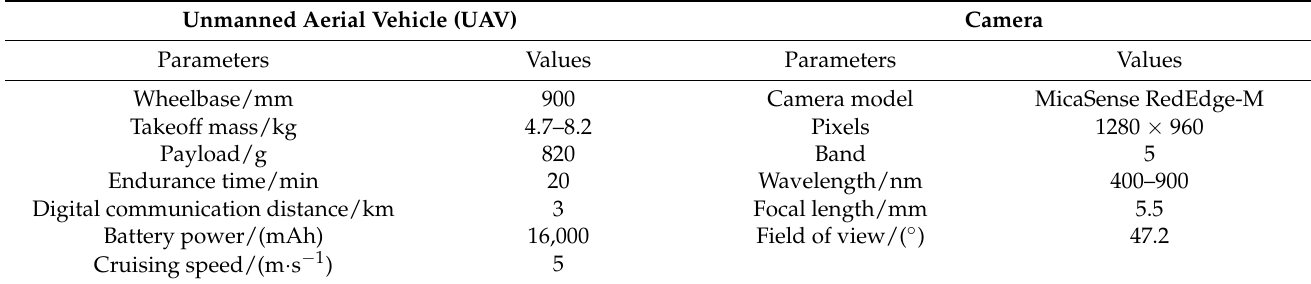
Table 1. Main parameters of the unmanned aerial vehicle (UAV) and camera.